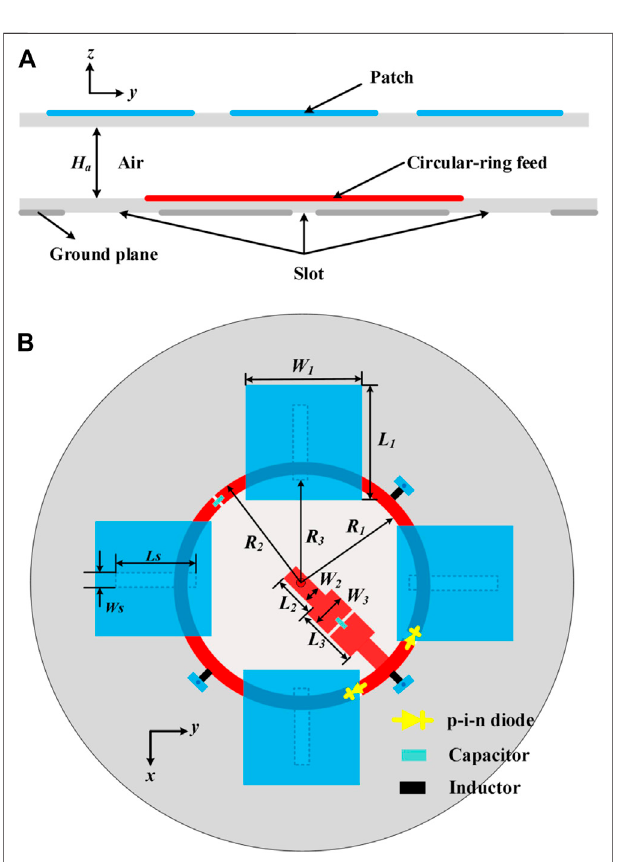
FIGURE 2 | Side and top views of the proposed polarization recon fi gurable antenna: (A) Side view; (B) Top view.